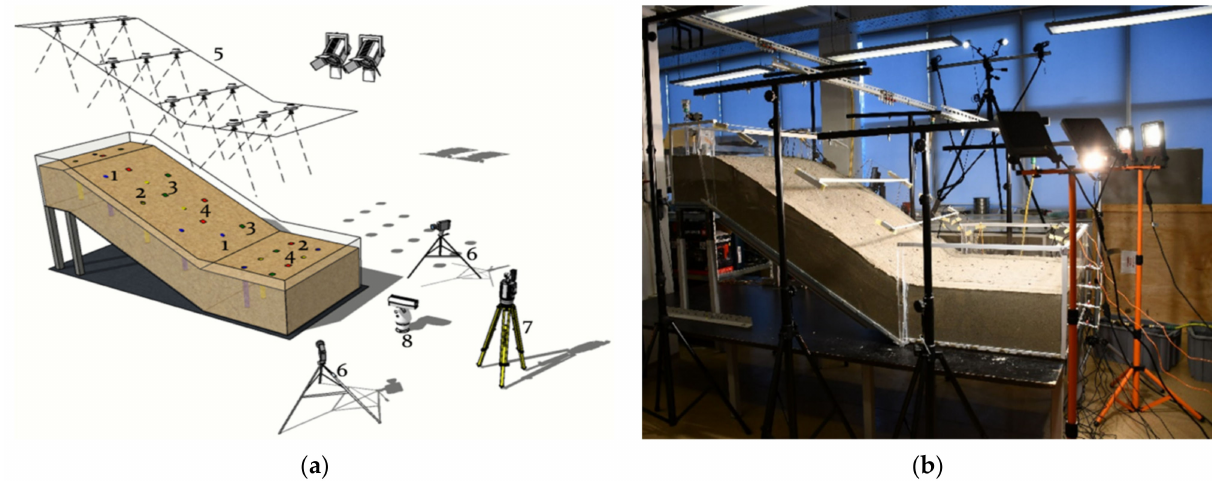
Figure 1. ( a ) Schematic view of the physical model with monitoring equipment: (1) tensiometers, (2) pore pressure trans- ducers, (3) strain gauges, (4) accelerometers, (5) rainfall simulator (sprinkler system), (6) high speed cameras, (7) terrestrial laser scanner (TLS), (8) infrared camera; ( b ) photo of the physical model [31–33].